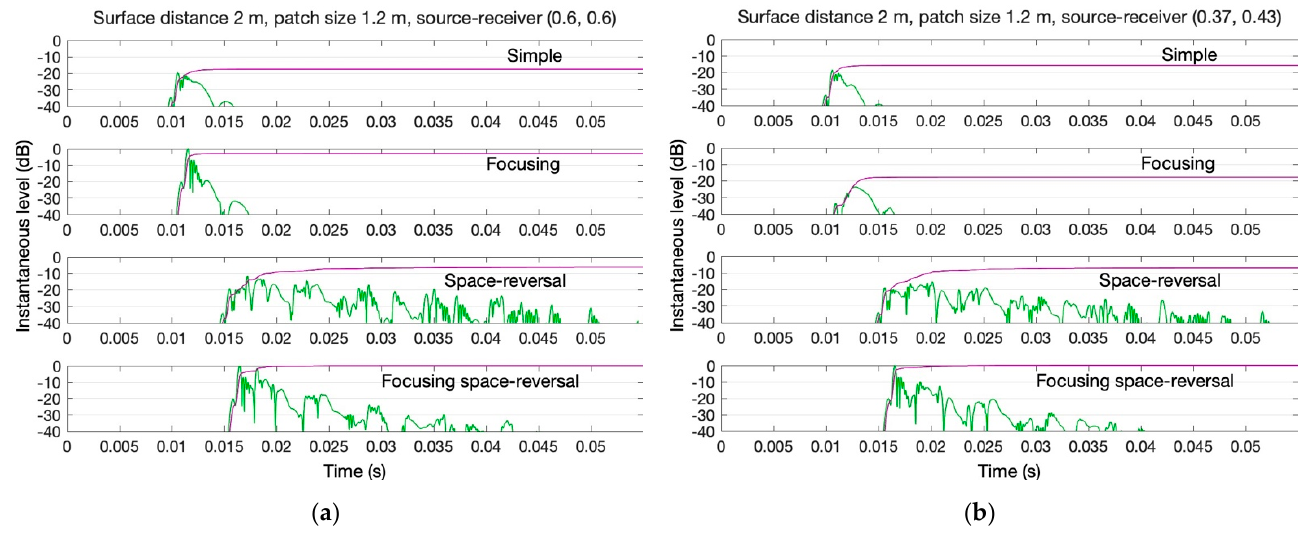
Figure 10. Examples of the time distribution of retroreflected impulse response for the four patch types for the large reflector: ( a ) source-receiver at a patch focus ( b ) source-receiver not at a patch focus. The envelope of the speech-A-weighted impulse responses (absolute value of the Hilbert transform) is shown in green, relative to the maximum peak. The cumulative sum of retroreflected energy is shown in magenta, relative to the greatest maximum value (i.e., focusing